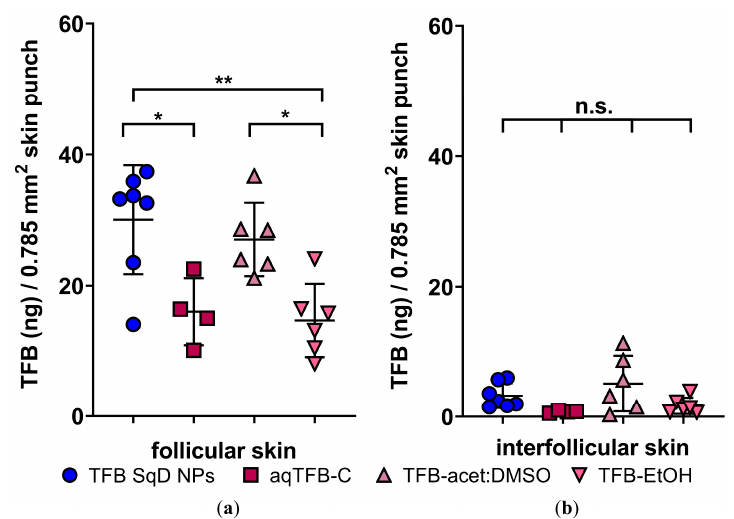
Figure 4. TFB deposition in nanograms per 0.785 mm 2 skin punch of surface-cleaned application area in ( a ) follicular skin and ( b ) interfollicular skin. Treatment groups are presented as TFB SqD NPs in blue circles, aqTFB-C in dark red squares, TFB-acet:DMSO in purple upward triangles, and TFB-EtOH in pink downward triangles respectively. Results presented as mean ± SD in a scatter dot plot. Significant differences are presented as p ≥ 0.05: n.s., p = 0.01 to 0.05: *, and p = 0.001 to 0.01: **, tested for follicular and interfollicular skin separately by one-way ANOVA with multiple comparisons by a Tukey’s test.